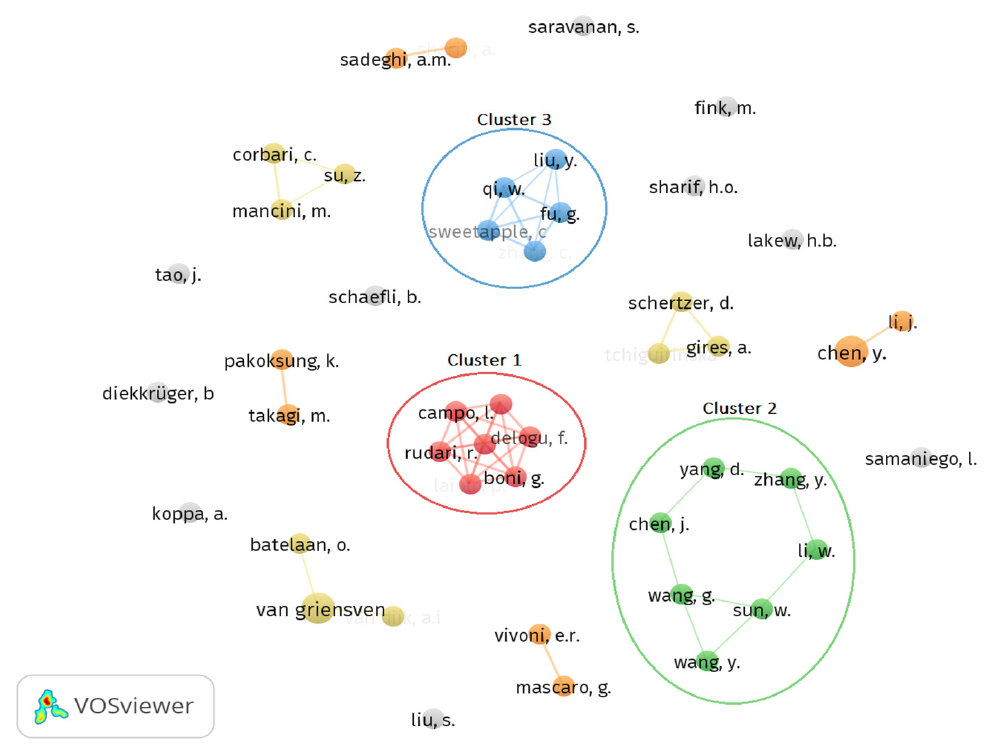
Figure 3. Clusters of authors collaboration patterns (the size of node is proportional to number of articles by the author).